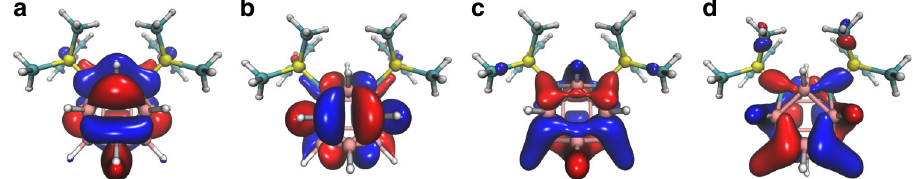
Fig. 3 Selected molecular orbitals of 16-vertex closo -carborane 5b calculated at the B3LYP/6-31G(d,p) level of theory. a LUMO + 1. b LUMO. c HOMO- 4. d